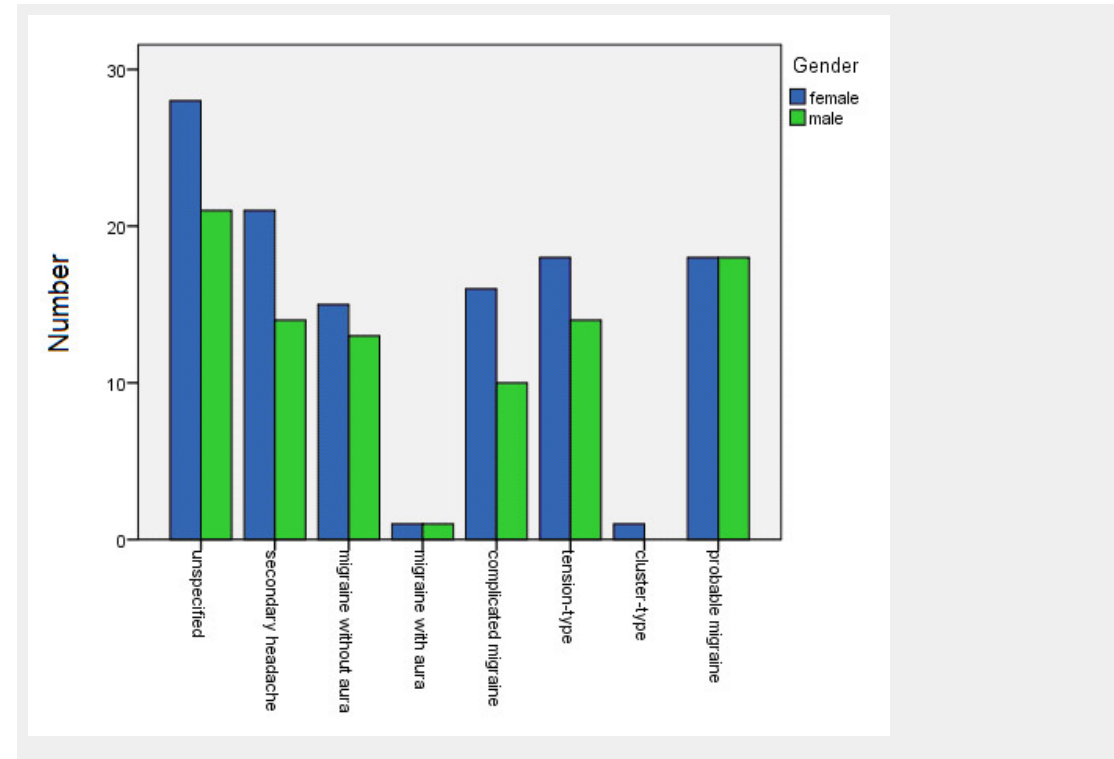
Figure 2b Type of headache seen in our patient cohort depending on